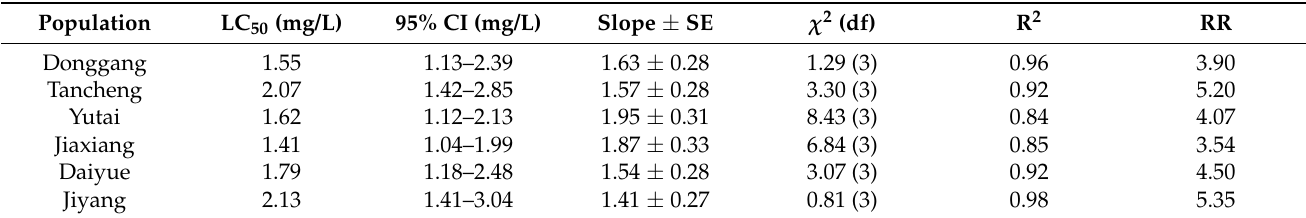
Table 5. Sensitivity to sulfoxaflor in six L. striatellus populations in Shandong Province.